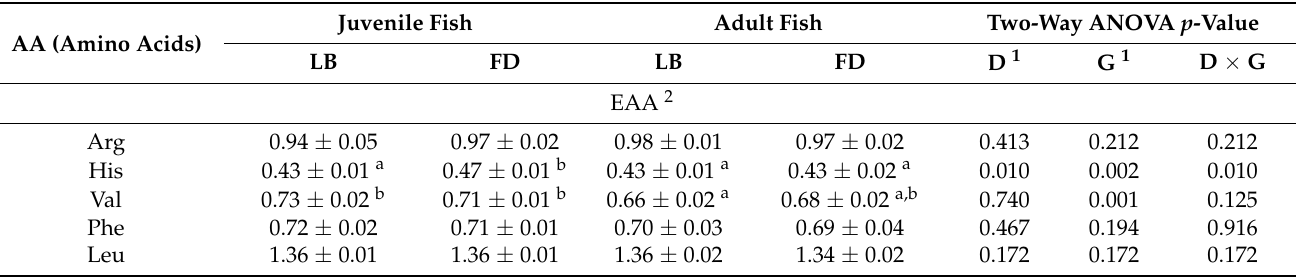
Table 5. Effects of live baits and formulated diet on the amino acid composition in muscle of Siniperca chuatsi at different growth stages (g/100 g, wet) 1